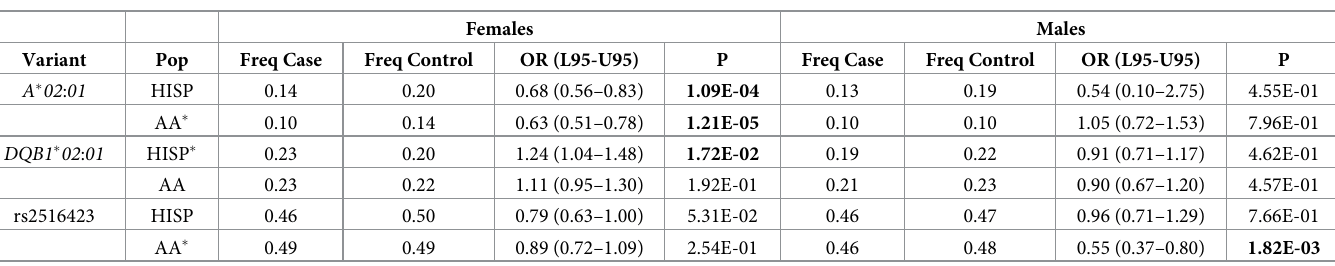
Table 4. Sex stratification.